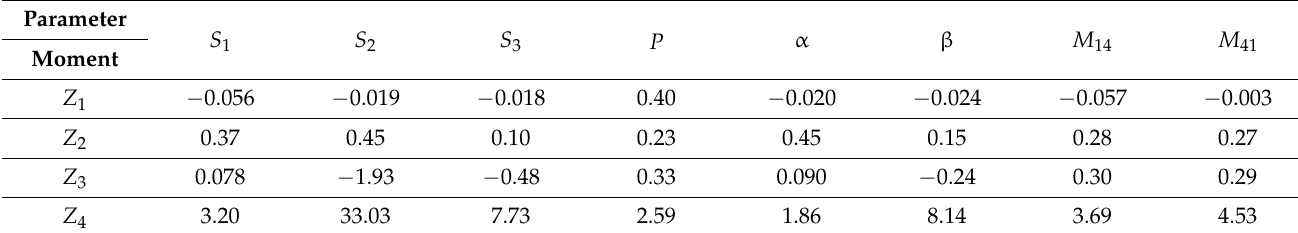
Table 1. Statistical moments of coordinate distributions of polarization parameters of a